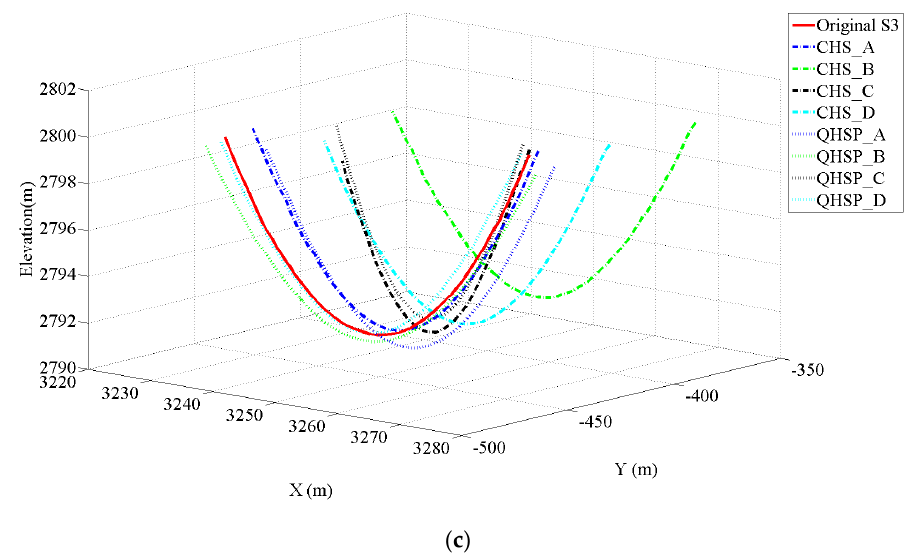
Figure 9. Constructed cross section ( a ) S1, ( b ) S2, and ( c ) S3 for the river with the amplitude of 600 m.